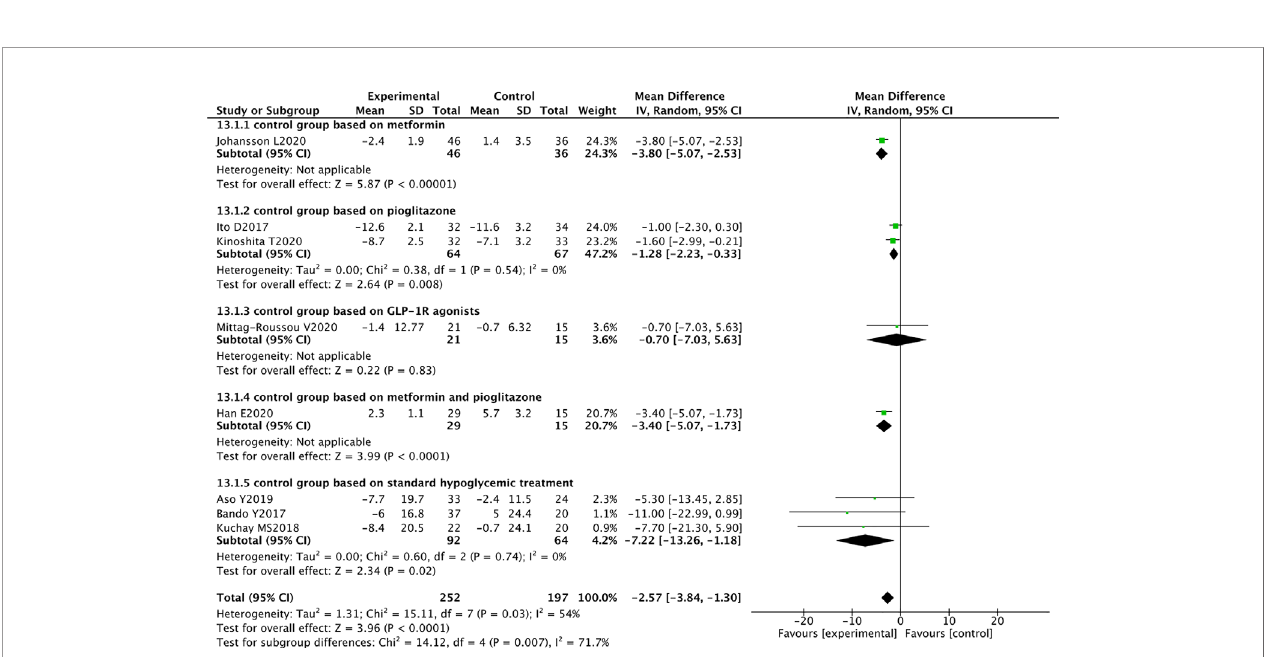
FIGURE 6 | Meta-analysis of AST level comparisons between SGLT2 inhibitors and the control group based on the control.